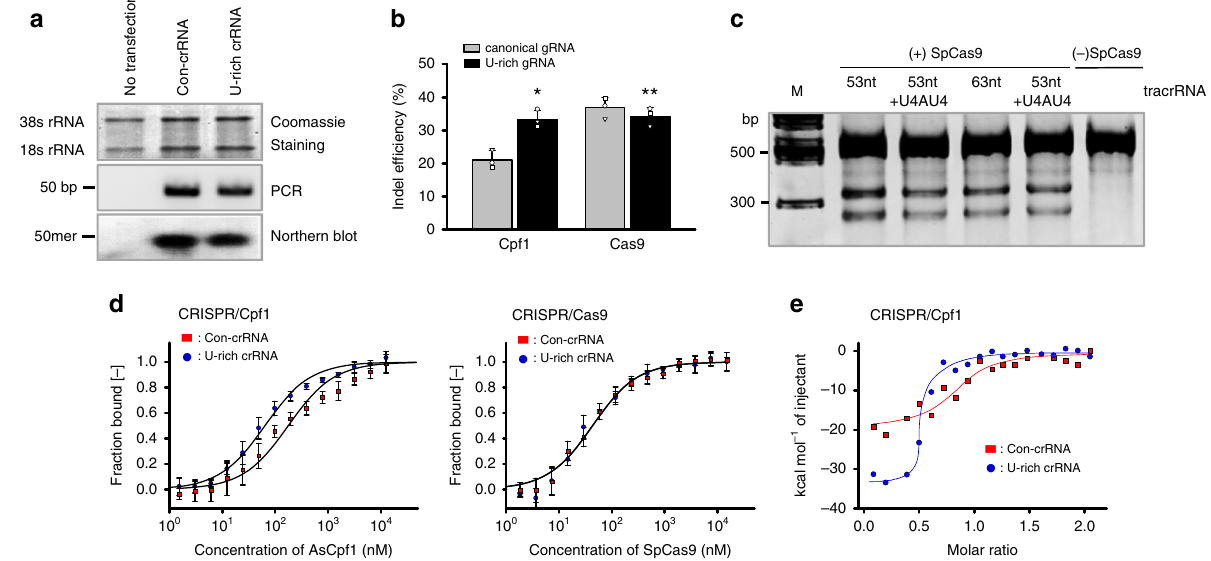
Fig. 6 Improved binding af fi nity of the crRNA-AsCpf1 complex by the U-rich 3 ′ -overhang. a The endogenous levels of the crRNAs were assessed by northern blot analysis following transfection of the crRNA template PCR amplicons into HEK293-T cells. The intracellular levels of 38s/18s RNA were used as a loading and quality control of the endogenous RNAs. The transfection ef fi ciency was also controlled by the PCR intensities of the crRNA template DNA isolated from the transfected HEK293-T cells. This result is representative of three repeated experiments. b The indel ef fi ciency was monitored at a DNMT1 locus following transfection of the AsCpf1 plasmid constructs and synthetic guide RNAs into HEK293-T cells. The 3 ′ -terminal four nucleotides of crRNA and sgRNA for AsCpf1 and SpCas9, respectively, were covalently linked with the phosphorothiate group. * p = 0.008, ** p = 0.39 ( n = 3), two-tailed Student ’ s t test. c The indel ef fi ciency was measured using the crRNA and tracrRNA of the CRISPR-Cas9 system. The truncated crRNAs with a length of 53 nt and 63 nt were compared with those with the U4AU4 3 ′ -overhang. This gel image is representative of three repeated experiments. d Binding experiments were conducted using a microscale thermophoresis (MST) system. The binding af fi nities of guide RNAs and the effector proteins (SpCas9 and AsCpf1) were measured using Monolith NT.115 (NanoTemper Technologies GmbH). All samples were loaded into NanoTemper standard capillaries and repeated three times for each measurement. e Isothermal titration calorimetry (ITC) measurements were conducted on an Auto-iTC200 Microcalorimeter (GE Healthcare) at 25 °C in PBS buffer (pH 7.4). The puri fi ed recombinant AsCpf1 proteins (5 μ M) were titrated with 50 μ M synthetic crRNAs with 2 μ L injections. K a = (1.90±0.87) × 10 8 M − 1 for the U-rich crRNA and (1.15±0.54) × 10 7 M − 1 for the canonical crRNA. Δ H = – 31.92±1.79 kcal/ mol and − 22.86±1.86kcal/mol for the U-rich and canonical crRNA, respectively. The values are the average of three independent experiments